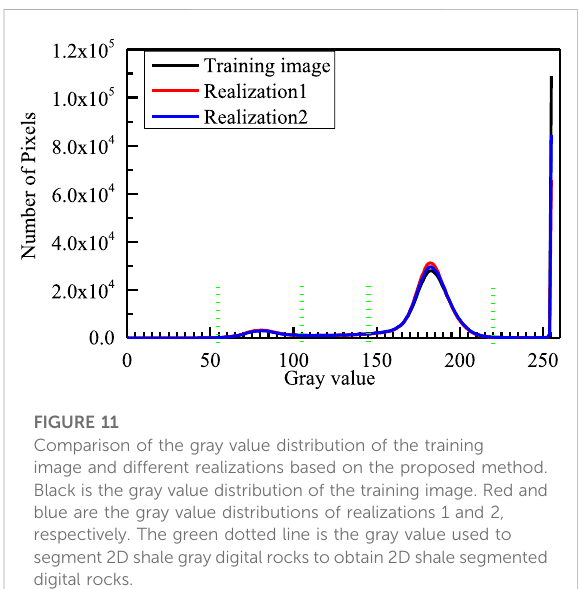
FIGURE 11 Comparison of the gray value distribution of the training image and different realizations based on the proposed method. Black is the gray value distribution of the training image. Red and blue are the gray value distributions of realizations 1 and 2, respectively. The green dotted line is the gray value used to segment 2D shale gray digital rocks to obtain 2D shale segmented digital rocks.